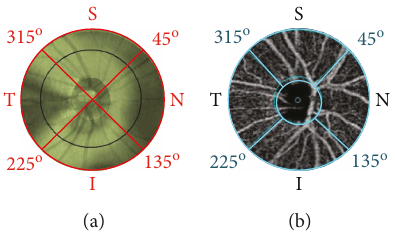
Figure 1: Peripapillary RNFL thickness and vessel density at quadrants were identi fi ed by OCTA. The boundaries of segmentation are indicated by the red lines ((a) peripapillary RNFL thickness) or blue lines ((b) peripapillary vessel